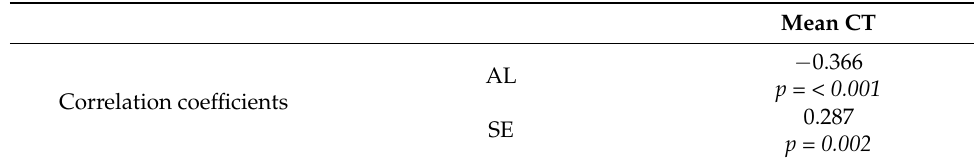
Table 3. Correlations between biometric factors and mean CT (2–5 years old age group) n = 16. Correlation coefficients Table 4. Correlations between biometric factors and mean CT (6–17 years old age group) n = 112. Correlation coefficients